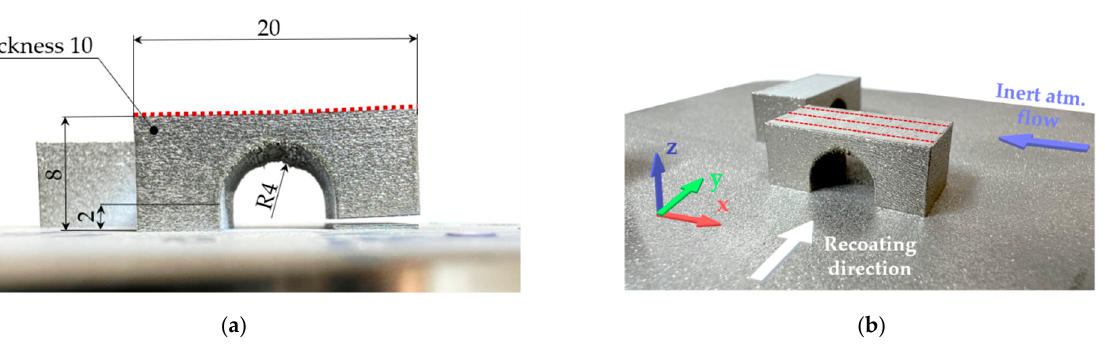
Figure 2. Bridge-shaped specimens: ( a ) specimen in the cut state with dimensions and marked top surface (red dotted line); ( b ) layout on the platform in the as built state with marked virtual section for measuring top surface distortion.